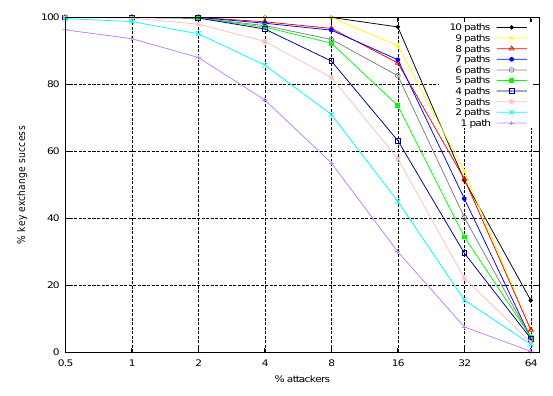
Figure 9. Success rates comparison by disjoint paths number (20k-node ER-model graphs with rerouting capped at 64 hops.